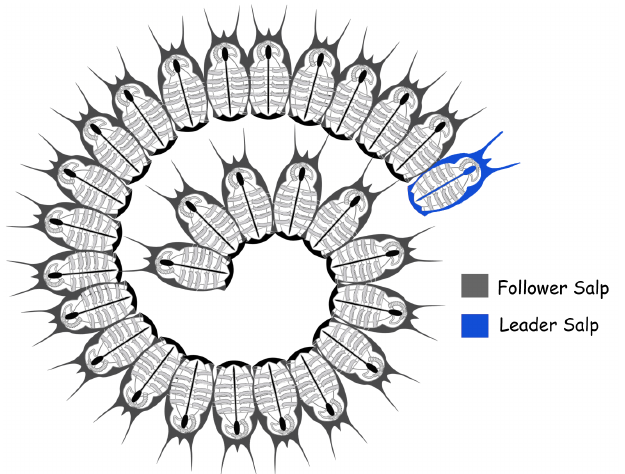
Figure 1. A representation of the SSA algorithm, which shows the leader and follower